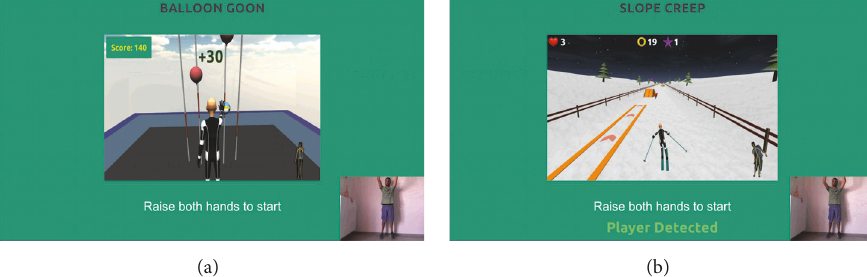
Figure 2: Screen snapshots displaying the “Stretch Arms High to Select” gesture in action; starting from the relaxed upright standing posture shown in Figure 1(a) for the Balloon Goon game or from that shown in Figure 1(c) for the Slope Creep game, the player can raise both hands high as shown in (a) or (b) in the current figure, respectively, to activate the game shown.